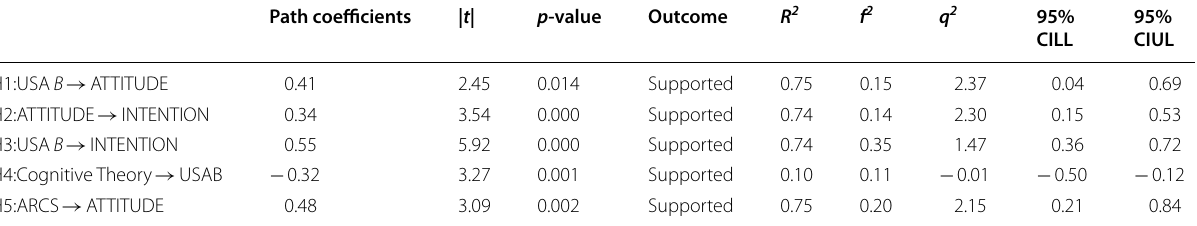
0.069, RMS_theta =